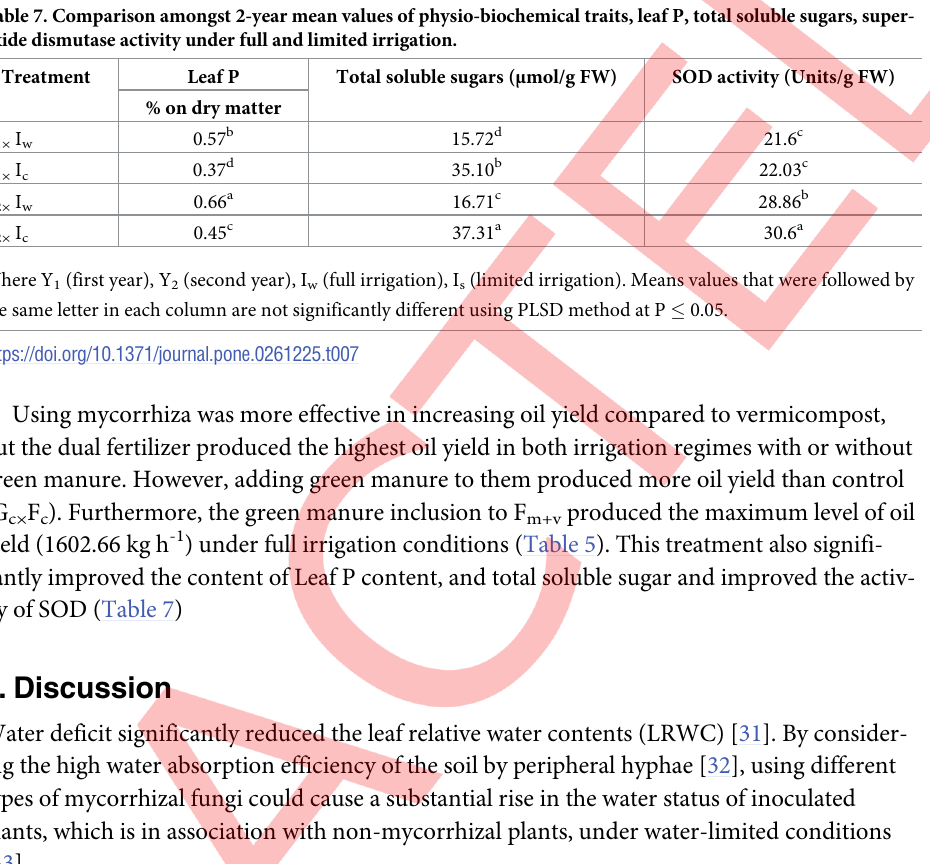
Table 7. Comparison amongst 2-year mean values of physio-biochemical traits, leaf P, total soluble sugars, super- oxide dismutase activity under full and limited irrigation. Treatment Leaf P Total soluble sugars ( μ mol/g FW)